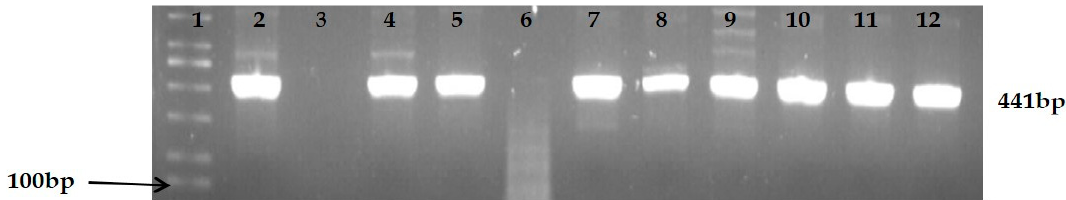
Figure 2. PCR products of the amplification of gyrA gene. Lane1: 100 bp molecular weight marker; Lane 2: positive control (ATCC 35657); Lane 3: negative control; Lanes 4–12: positive Klebsiella spp. isolates.